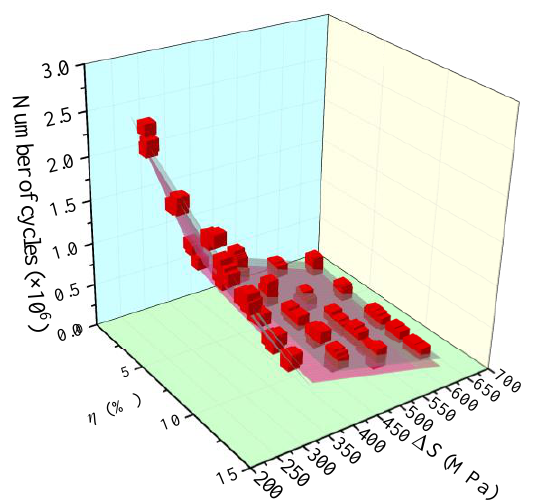
Figure 17. Relationship between fatigue life of pre-corroded steel wire and mass loss rate. The fatigue life and corrosion degree of steel wires with different survival probabili- ties under different stress ranges are shown in Figure 18. Combined with the measured experimental data, the fatigue data are scattered on the corresponding median curve, with most data points between 10% and 90% survival probability.